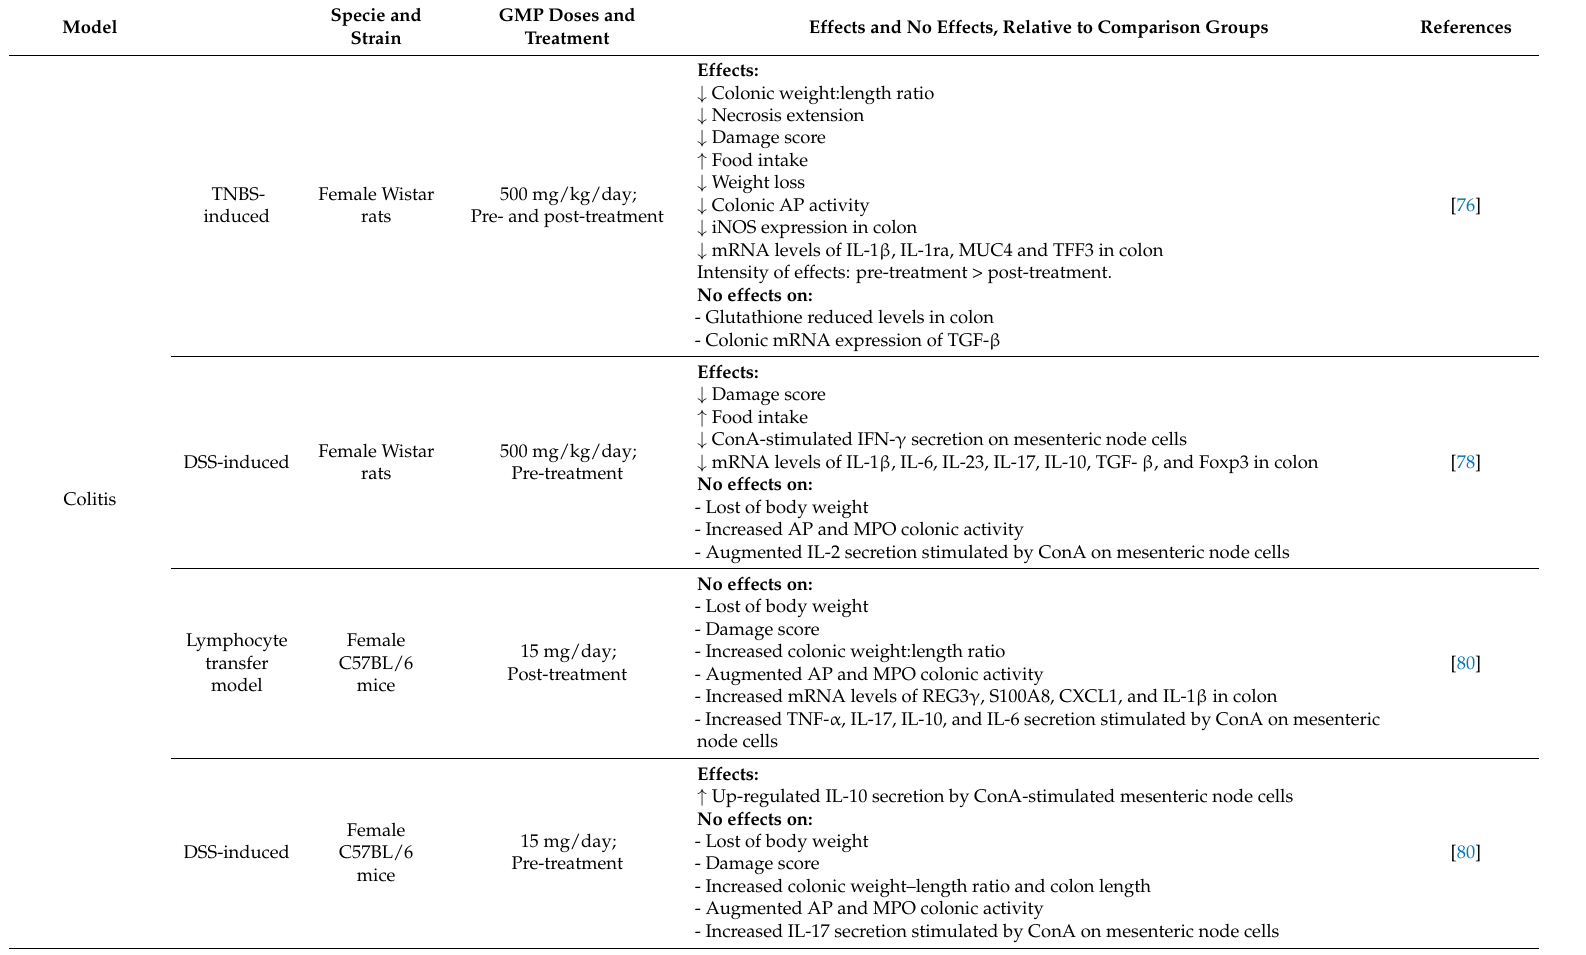
Table 1. Glycomacropeptide in rodent models of inflammatory